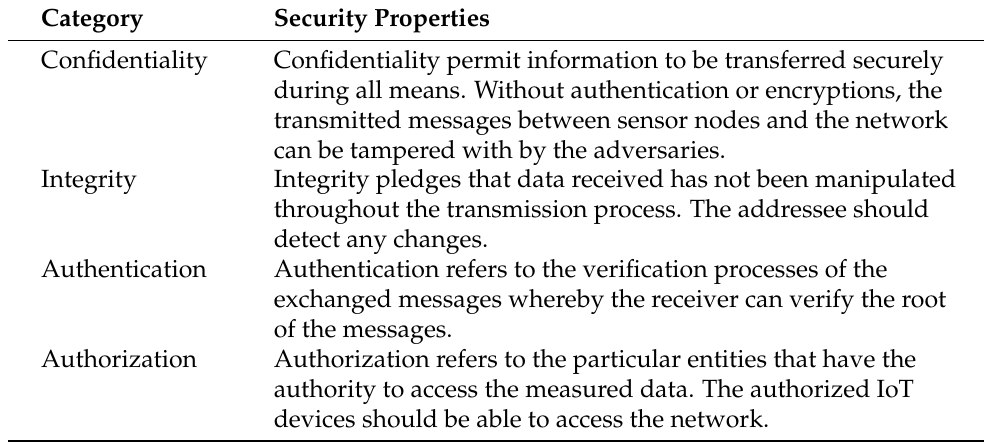
Table 1. Basic security properties for